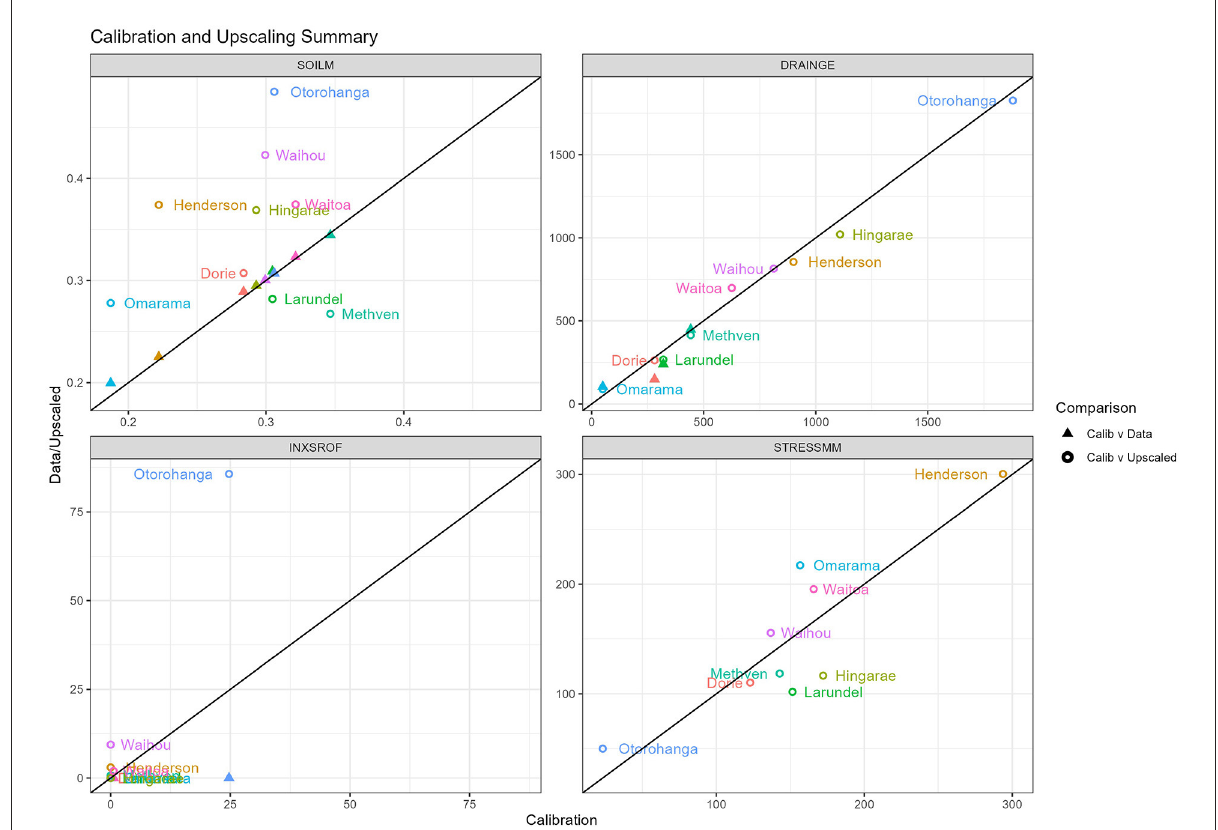
FIGURE10 Calibration and upscaling performance. Model annual summaries compared with data [triangles: mean soil water content (SOILM) (m 3 /m 3 ) at nine sites, and total drainage (DRAINGE) (mm/y) at four sites] and predictions of these variables as well as INXSROF (mm/d) and STRESSMM (m 3 /m 3 ) based on upscaled parameters (circles).